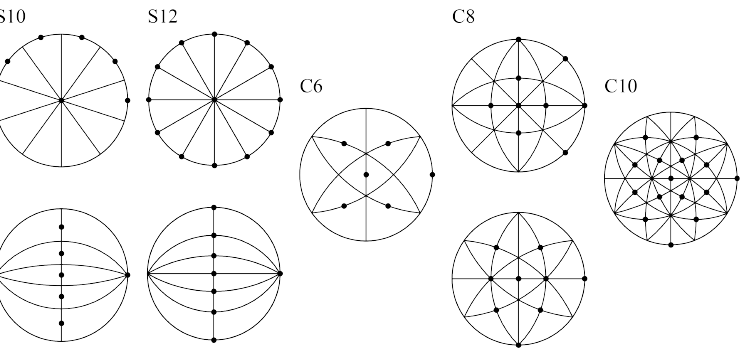
Figure 8. Stereographic projections of Temari basic